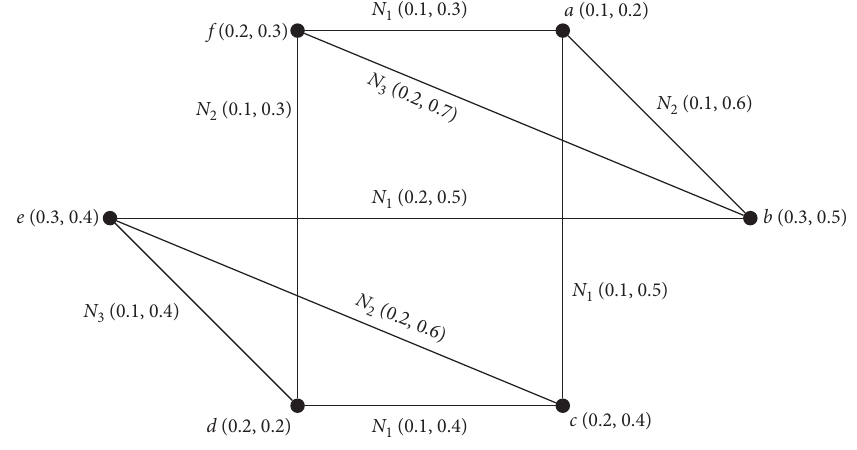
Figure 2: VGS ξ � ( M,N